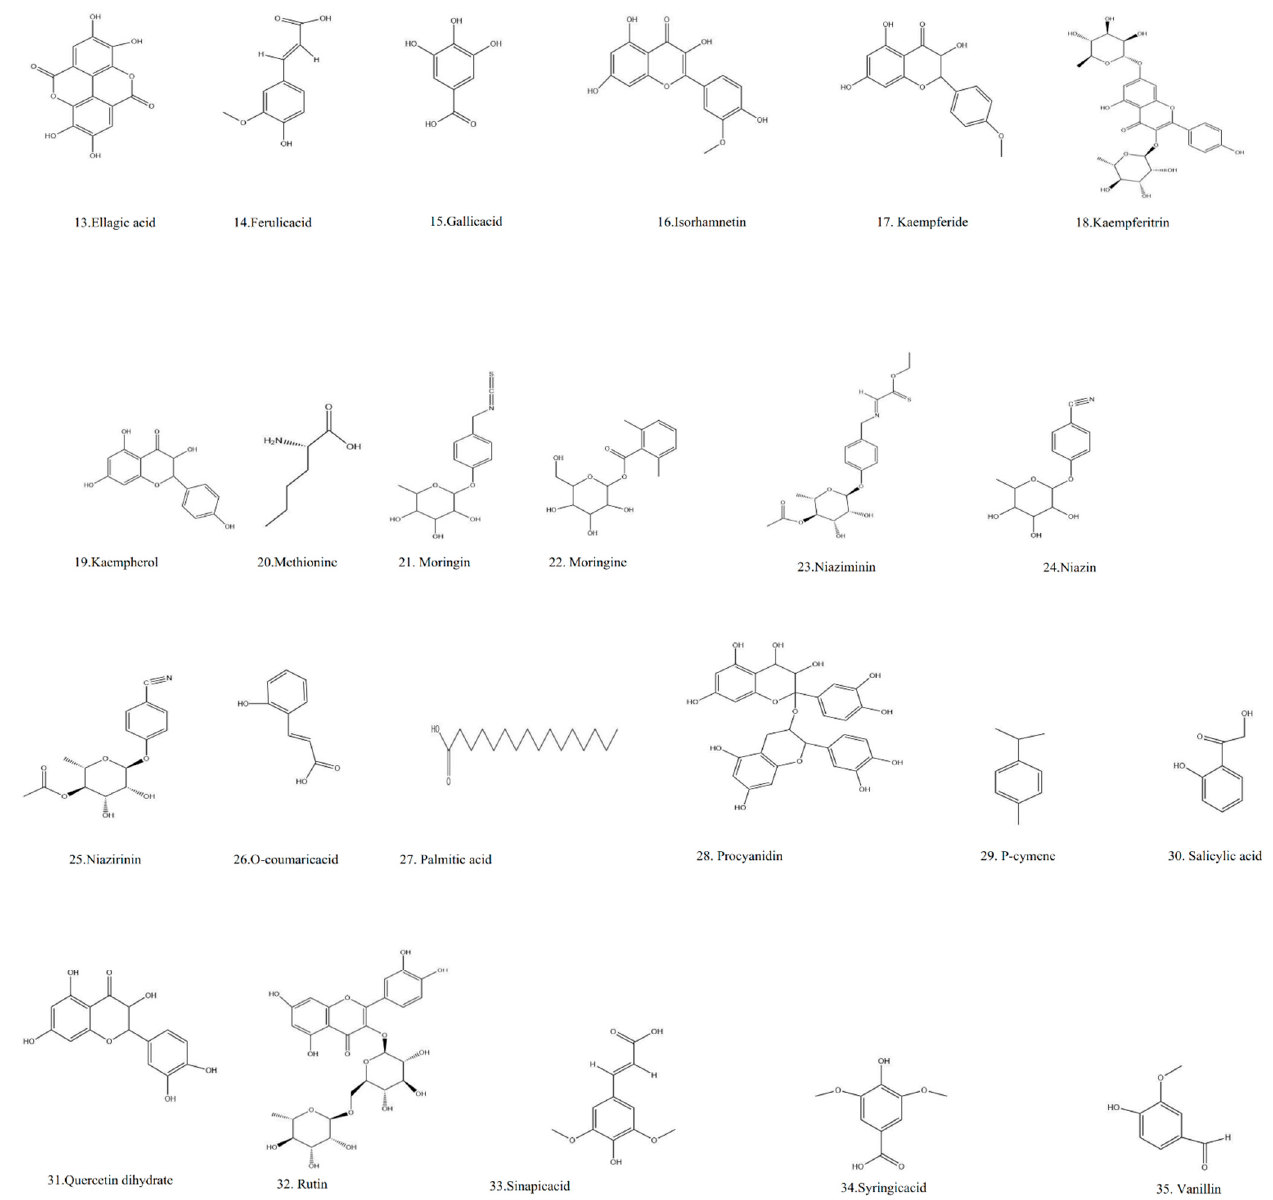
Figure 7. Structure of some key phytoconstituents isolated from M. oleifera.